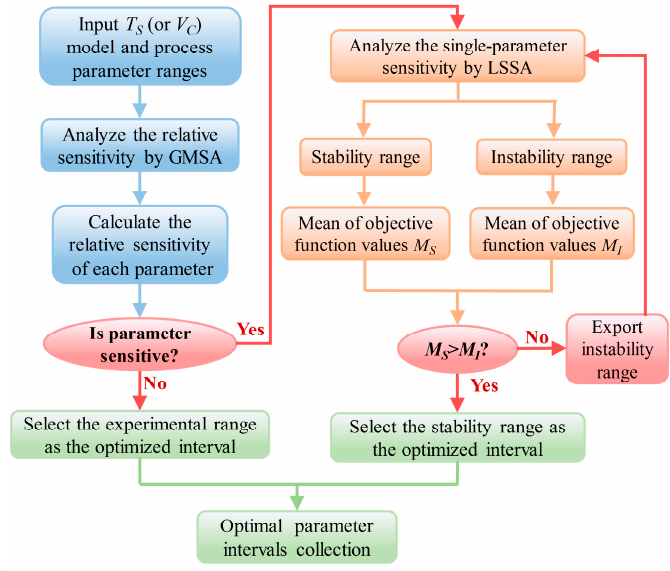
Figure 13. Flow chart of parameter interval optimization process.